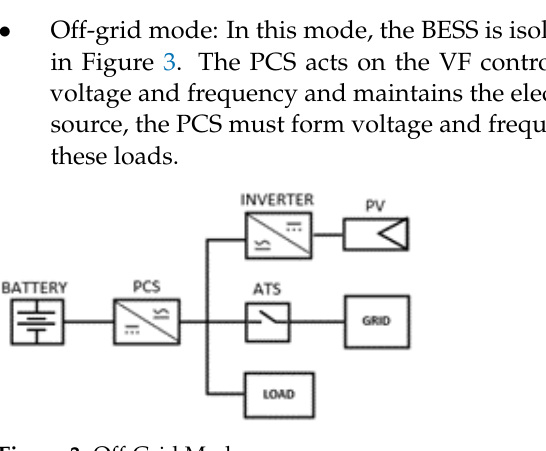
Figure 3. Off-Grid Mode.